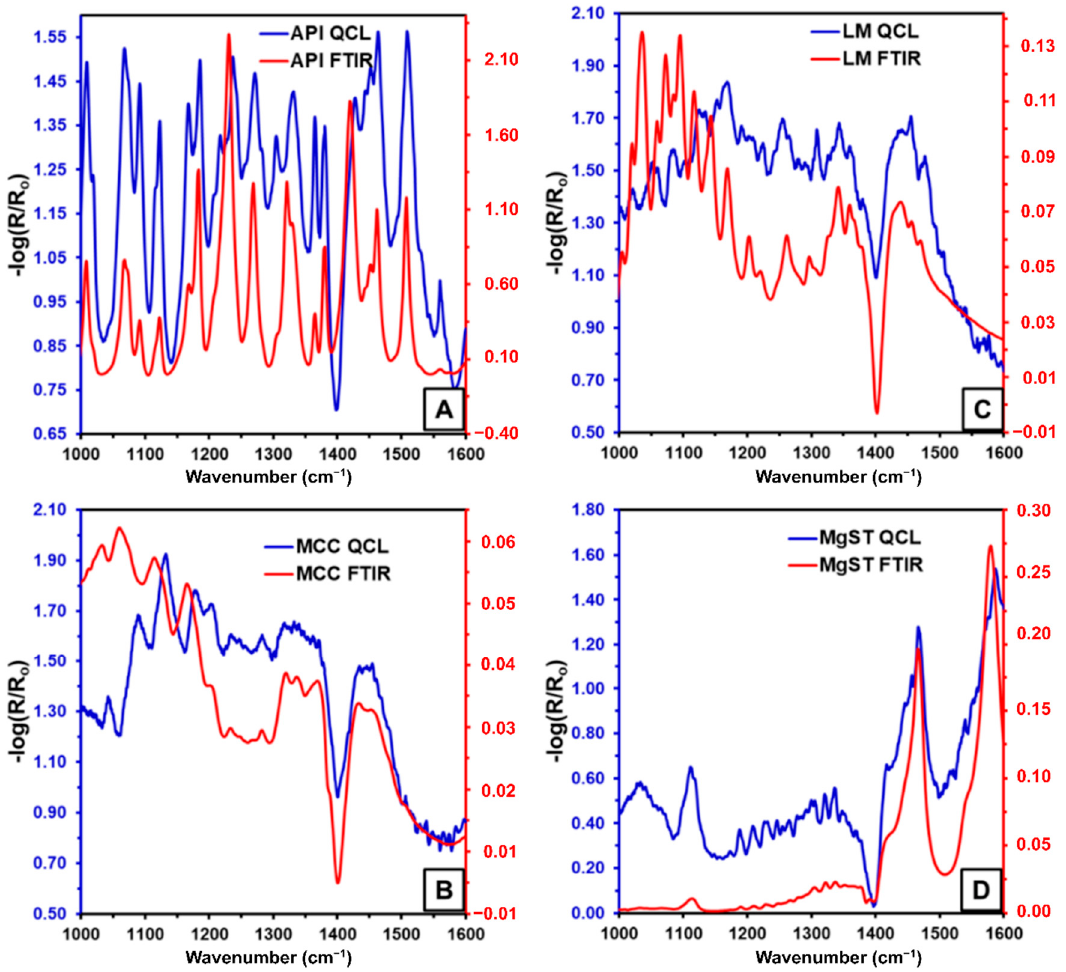
Figure 3. Comparison of the QCL FTIR diffuse reflectance spectra of pure components ( A ) IBU, ( B ) ML, ( C ) MCC, and ( D ) MgST.